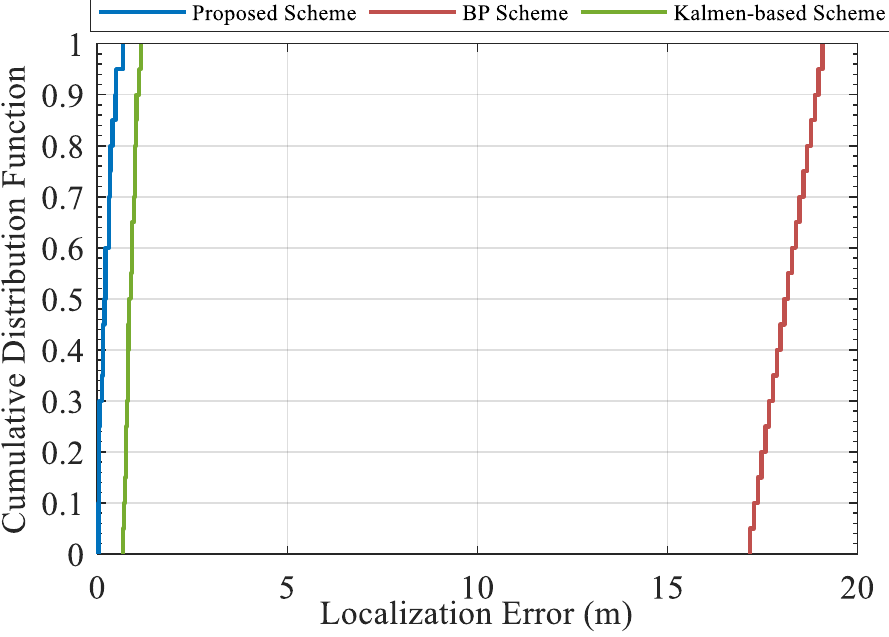
Figure 5. Cumulative distribution function for positioning error.